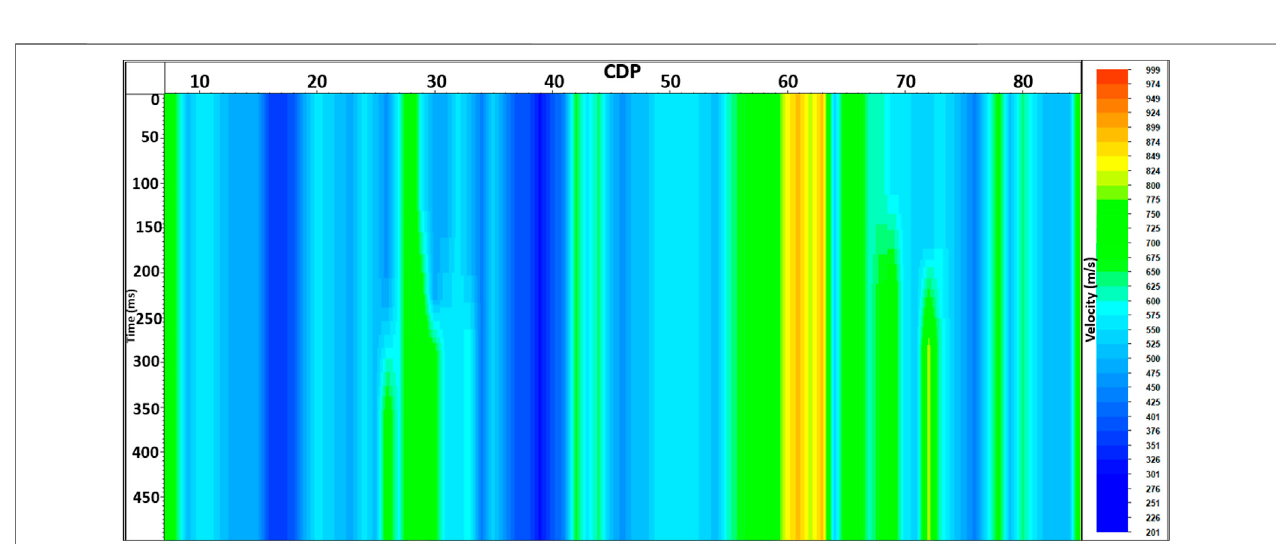
FIGURE 5 | The fi nal stacked velocity model of pro fi le A after the picking of available CMP gathers on semblance plots.